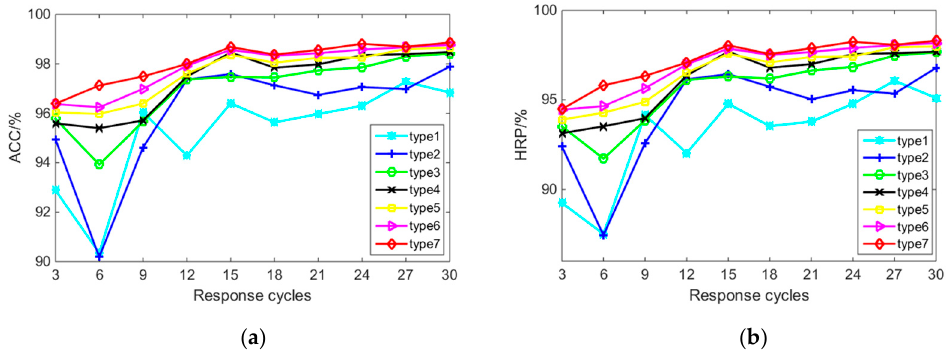
Figure 5. Performance of different types of CNN-based ensemble classifiers with different response cycles: ( a ) accuracy (ACC); ( b ) harmonic mean of recall and precision (HRP).